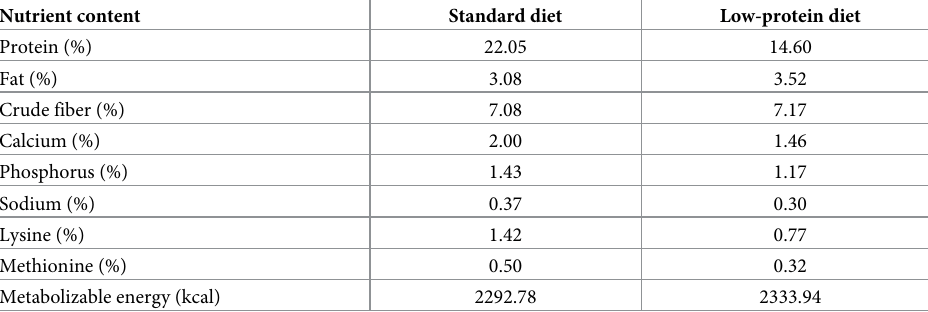
Table 1. Bromatological characteristics of the diets used for mice feeding. Nutrient